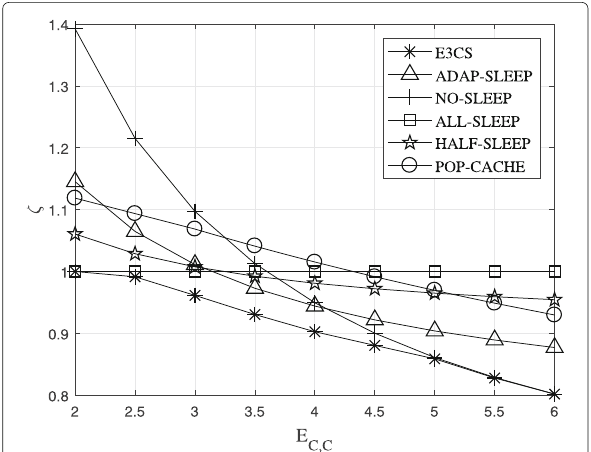
Fig. 3 Effect of the energy consumption E A for the active mode during τ